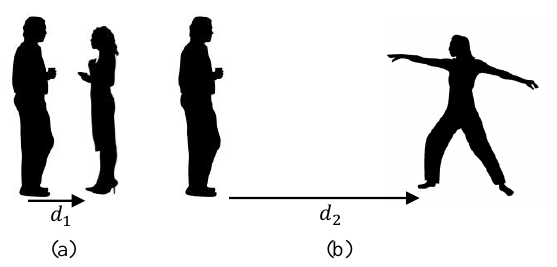
Figure 11. Motivation behind the method proposed in [72]. ( a ): a small interpersonal distance is sufficient since body joints are not much extended and not moving fast. ( b ): large interpersonal distance is required since body joints are widely extended with a considerable